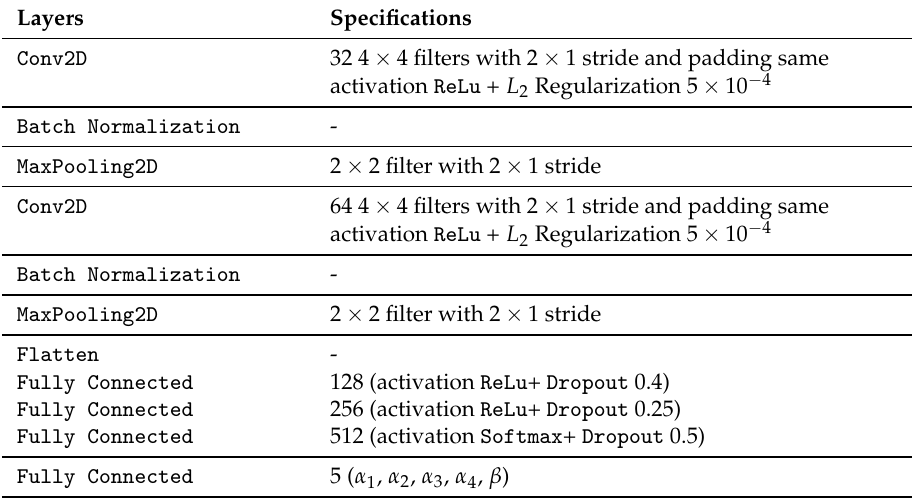
Table 1. Convolutional Neural Network structure and parameters